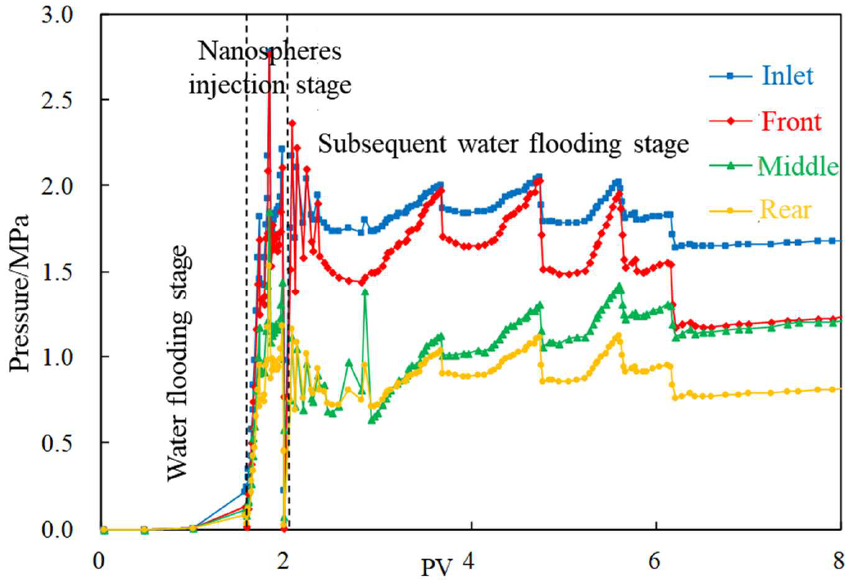
Figure 3. Pressure change curve (300 nm nanospheres).